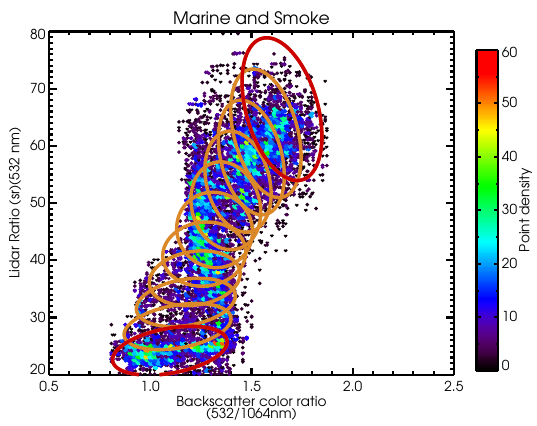
Fig. 10. Aerosol lidar ratio (532nm) and backscatter color ratio (532 / 1064nm) measured by HSRL-1 on 28 March 2006 in the Gulf of Mexico. All measurements on this flight below 2500ma.s.l. and having extinction greater than 0.05km − 1 are shown in this figure. The measurements are shown as individual points, color coded by point density with warmer colors indicating higher point density (in arbitrary units). The red and orange ellipses represent two-sigma co- variance for pure smoke and pure marine (see text) and for mixtures of the two with a range of mixing